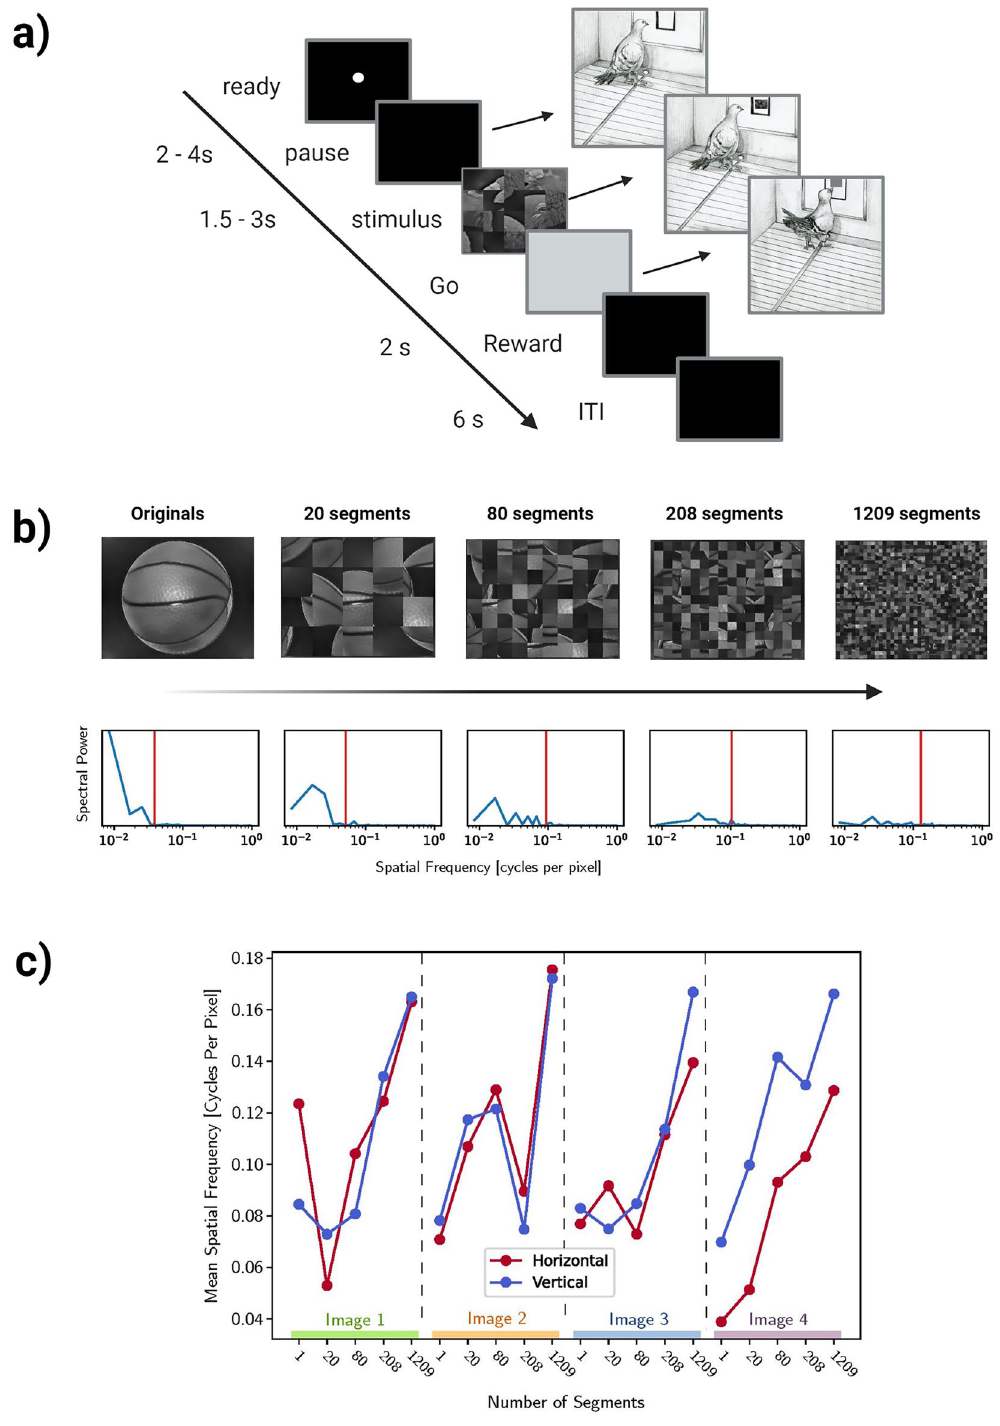
Figure 2. ( a ) A typical experimental trial started with two pecks to the orienting dot stimulus, initiating a pause period between 2 and 4 s with a black screen. An image was displayed in the response window for a random time (1.5–3 s) in the stimulus period. Pecks at the image started a correction repeat of the same trial from the start of the ITI. If the bird withheld pecks during the stimulus period, a Go cue (grey square) replaced the image on screen, and a peck to the Go cue delivered grain reward from the hopper, paired with a light and tone. A 6 s ITI followed the reward period. ( b ) Depiction of the progressive scrambling procedure for the original images (top) and corresponding spectral density plots (bottom). Low spatial frequencies are disrupted, and the average energy across spatial frequency bands increases (particularly high spatial frequencies) as the images become progressively more scrambled. The mean horizontal spatial frequency is highlighted by the red line, serving as an effective proxy for the changes in the distribution of spatial frequency components. ( c ) Spectral analysis of the image set showed that the progressive scrambling procedure generally resulted in an increase of high spatial frequency information across the horizontal and vertical directions at increasing levels of scrambling for each of the four original